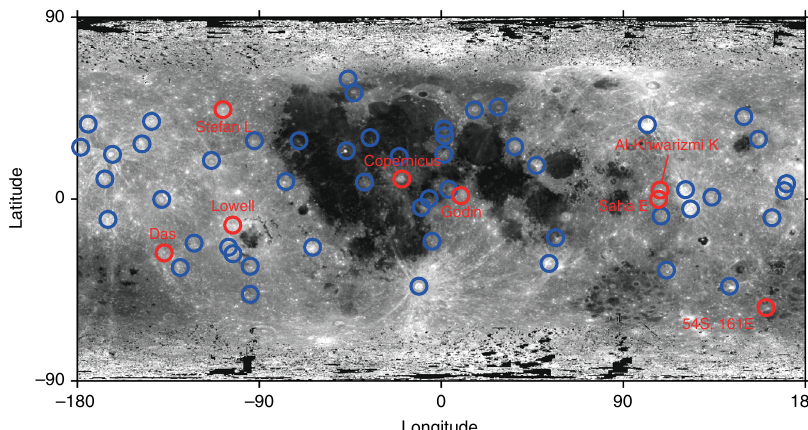
Fig. 1 The locations of the 59 investigated craters with fresh morphologies and diameters larger than ~20 km. The locations of the 59 investigated lunar craters with fresh morphologies and diameters larger than approximately 20 km are shown. The craters with ages the same as that of Copernicus crater are indicated by